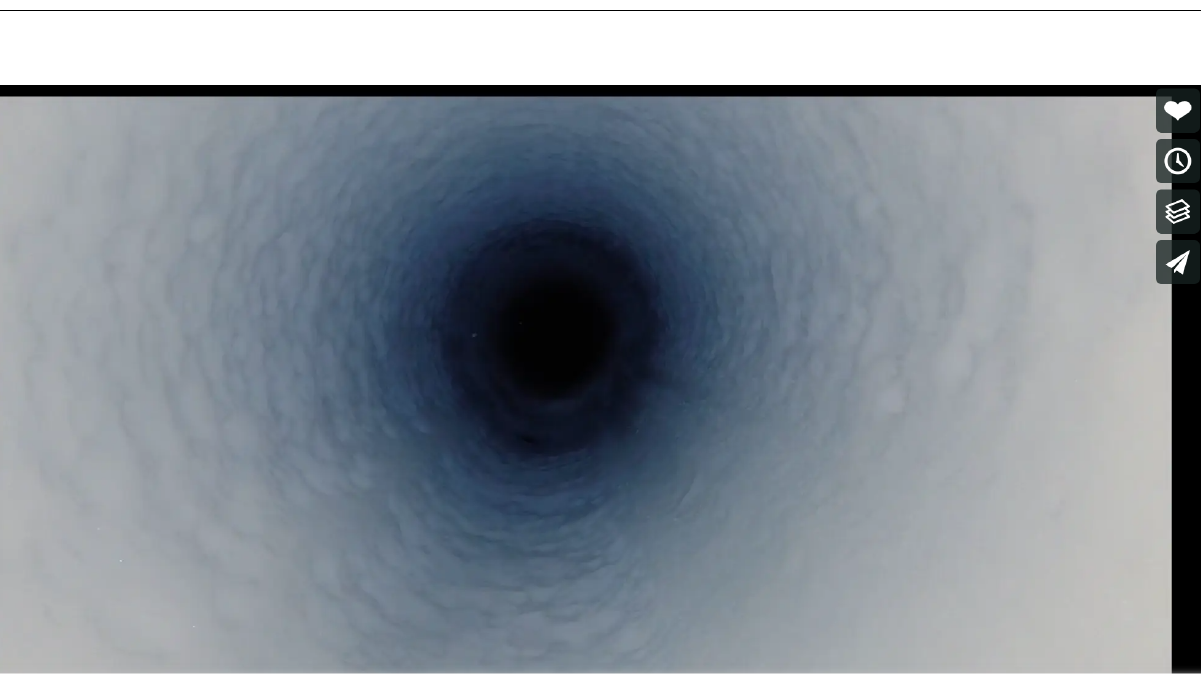
Figure 9: Video thumbnail, 3600 Feet Beneath the Ice - film trailer (4m 40s), 2020. Courtesy of Kathy Kasic and the SALSA Science Team. Trailer available at: